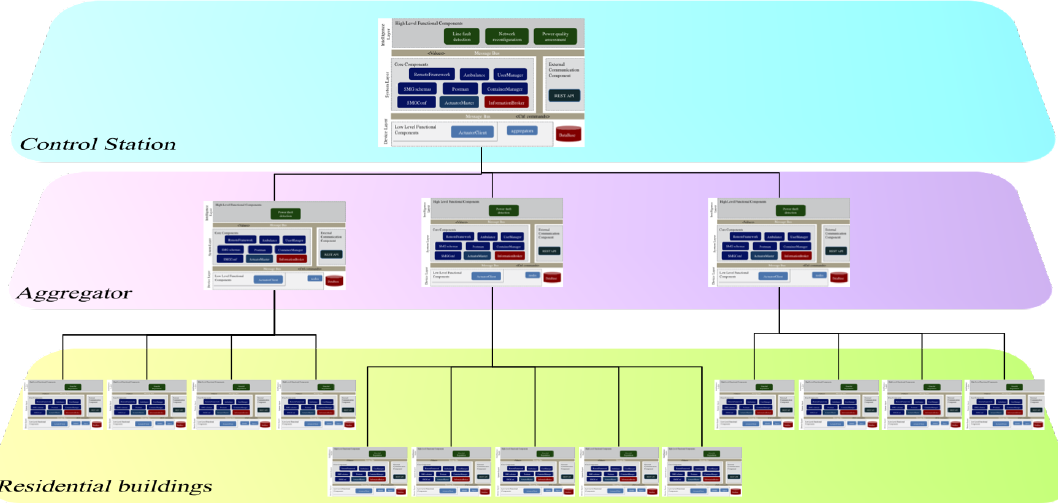
Figure 7. Complete view of the Microgrid Controller (MC) implementation at each layer in the 13-node distribution